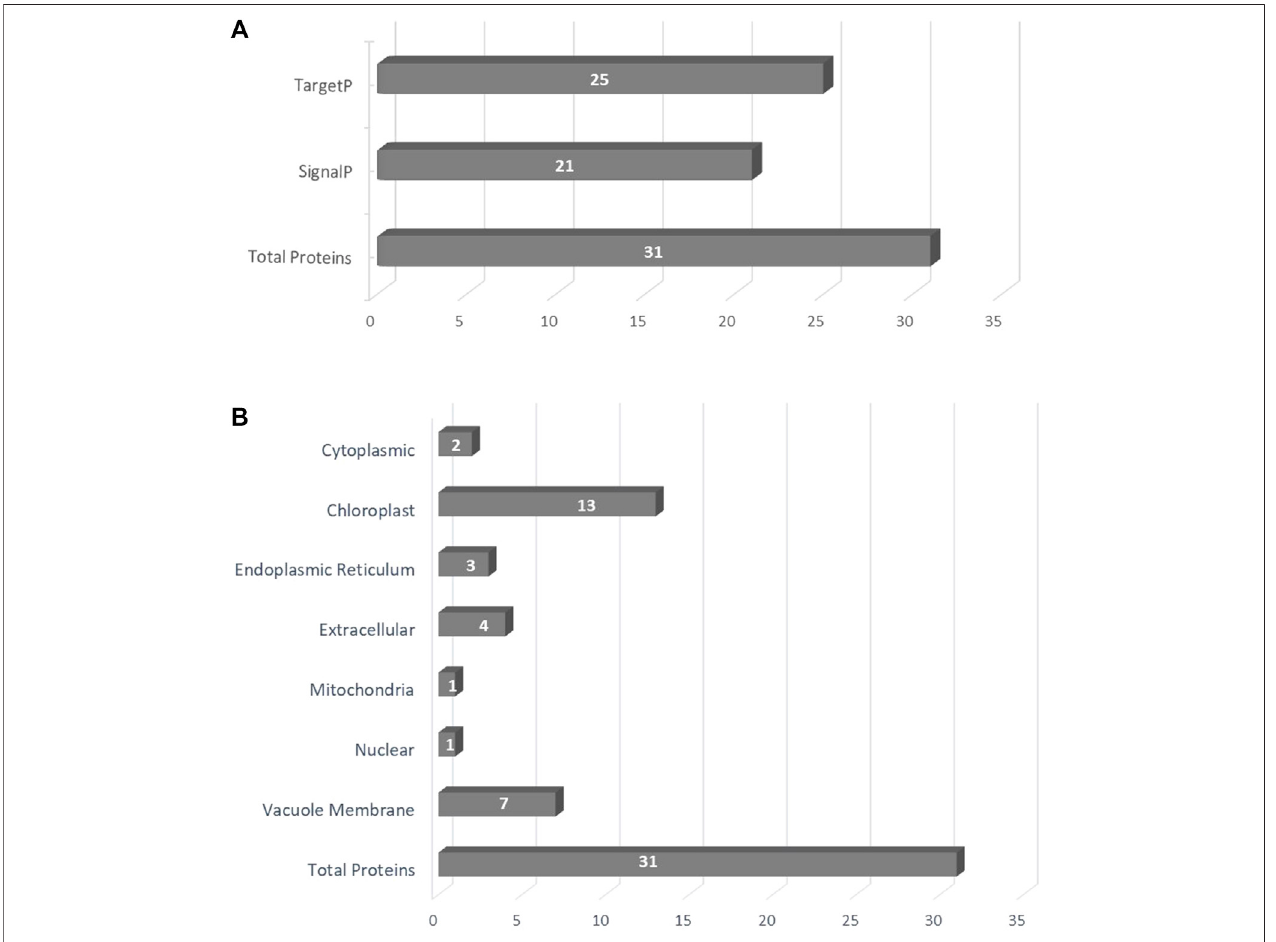
FIGURE 1 | (A) The subcellular localization of predicted proteins; (B) The presence of signal peptides in the analyzed sequences using SignalP and TargetP.